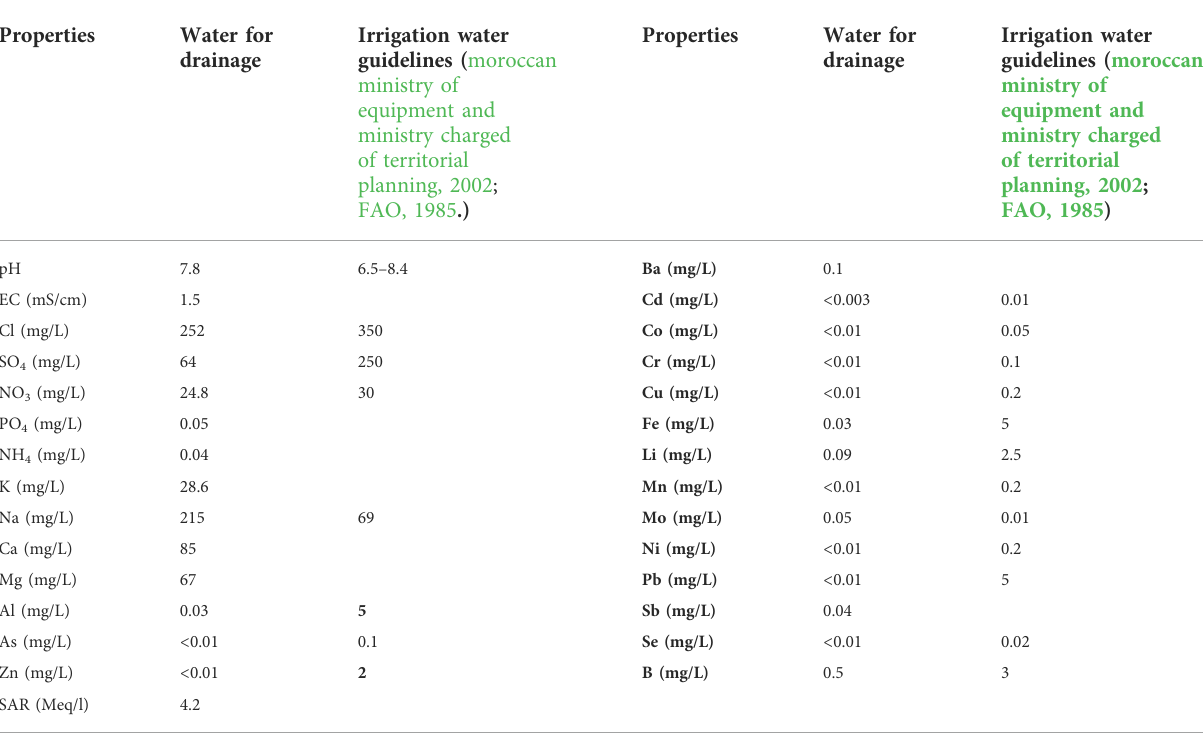
TABLE 3 Water for drainage chemical properties.